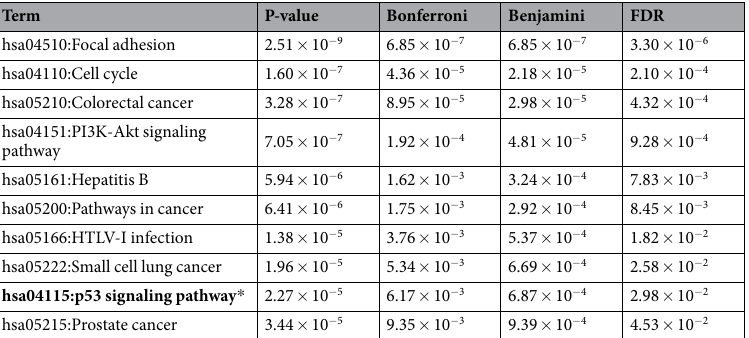
Table 4. Significant KEGG pathways corresponding to target union from miR-338 and miR-29b, with all of the Bonferroni, Benjamini and FDR values smaller than 0.05. * Bold pathway corresponds to significant pathway which is insignificant using targets from either miR-338 or miR-29b.